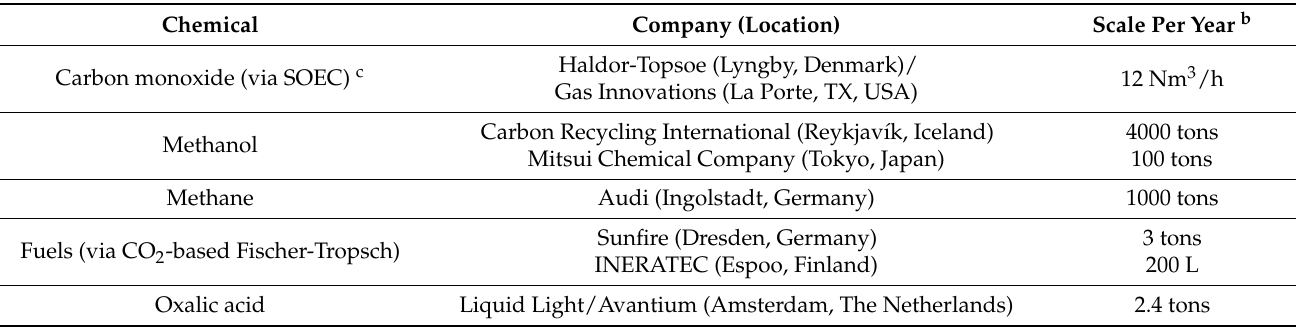
Table 4. Selected examples of chemicals currently synthesized from CO 2 on a pilot plant scale. a Reproduced with permission from [134], American Chemical Society,